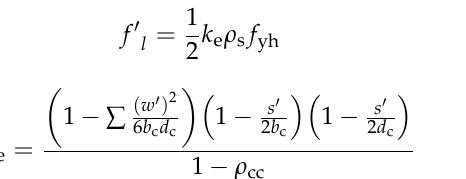
Figure 18. The division of concrete in SRC columns.